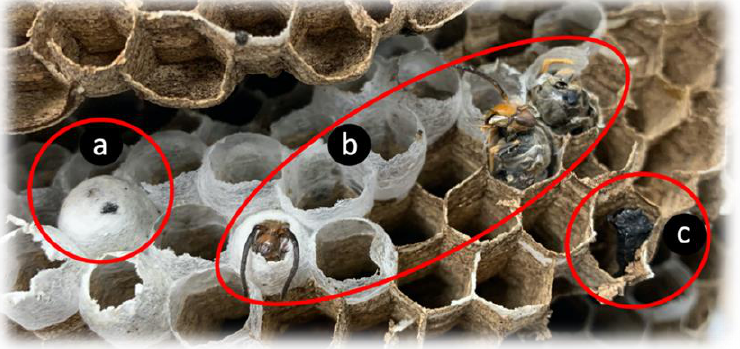
Figure 13. Nest individuals found after captivity studies. Operculated larvae that did not hatch ( a ), new hornets which did not emerge from the nest ( b ) and dead larvae ( c ).